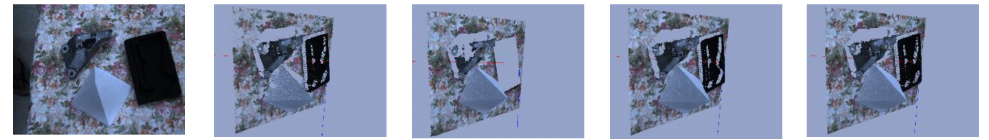
Figure 18. 2D color image and side of 3D point cloud obtained by using one optimal exposure and multi-exposure capture within the single projection.